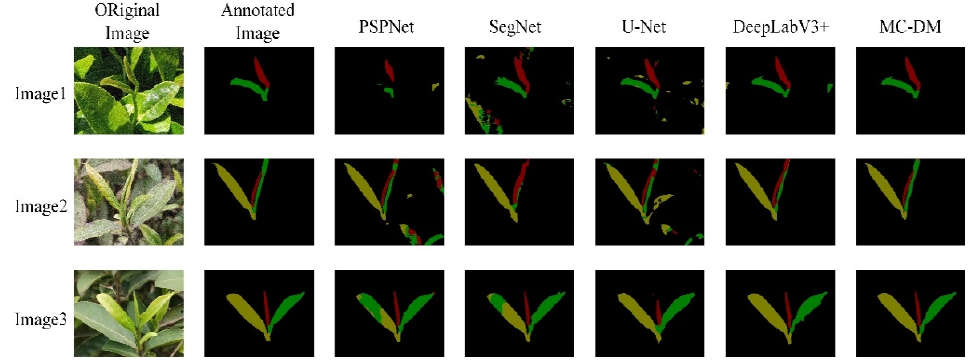
Figure 8. Prediction results of different segmentation models.